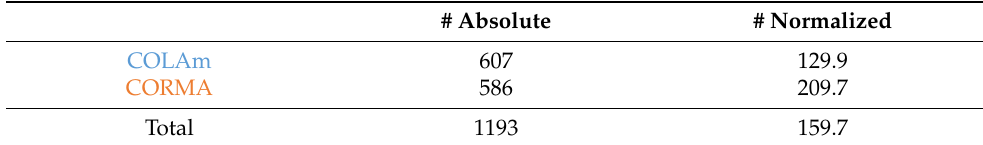
Table 5. Normalized frequency of vocatives per corpus.